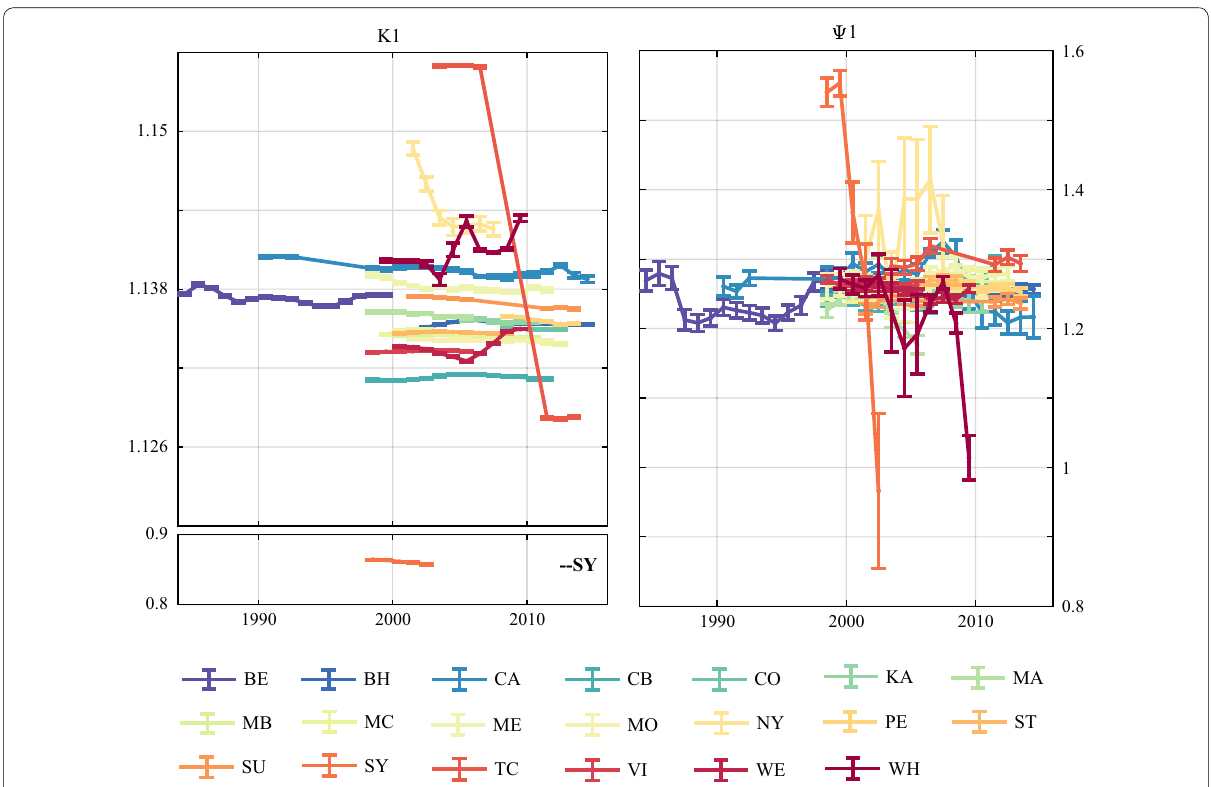
Fig. 5 Tidal analysis results of 20 observations from global stations in Table 1, in which the variation in the amplitude factor (real part) of the K1 (left) and ψ1 (right) waves is plotted with error bar. The abbreviation of station name in the legend follows Table